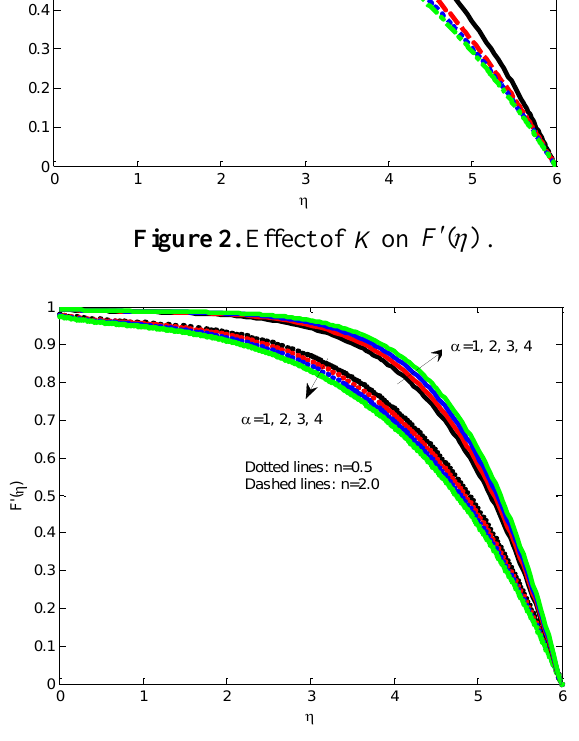
Figure 3. Effect of  on ( ) F 